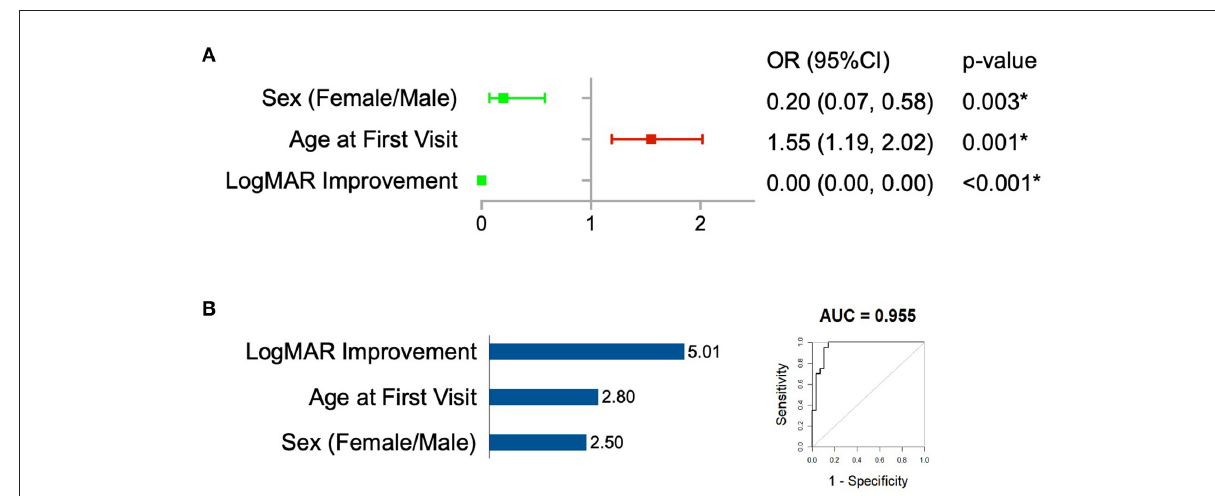
FIGURE3 Construction of prognostic models. (A) Forest plots of the 3 variables selected by LASSO regression. (B) The logistic regression model using variables selected by the LASSO regression (Left, variable importance ranking. Right, The model’s ROC curve). The * symbol indicates the statistically significant